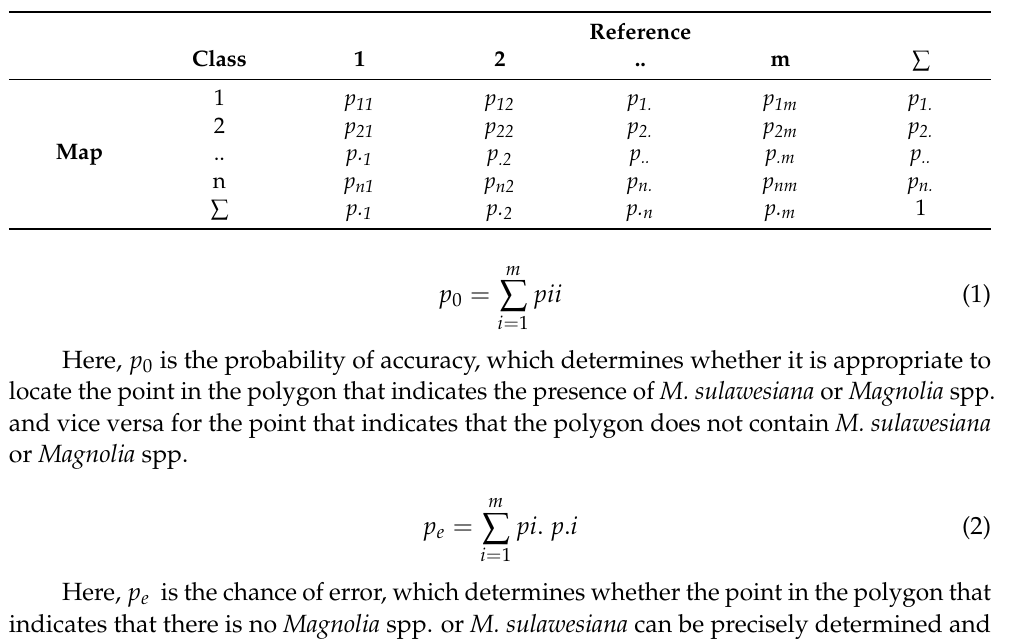
Table 3. Confusion matrix of the validation distribution